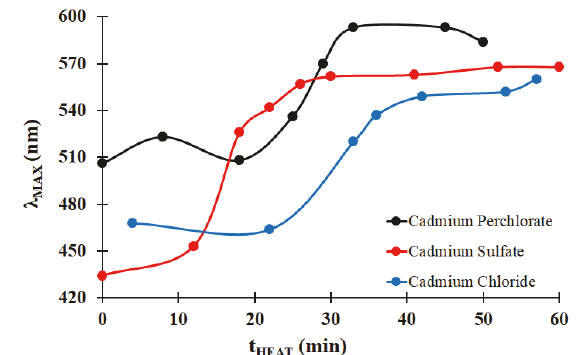
Figure 1: Fluorescence spectra of mercaptosuccinic acid-modified CdSe QDs. Different metal salts were used, with corresponding 𝜆 MAX values (acetate = 605 nm [fwhm = 111 nm], chloride = 610 nm [fwhm = 134 nm], nitrate = 617 nm [fwhm = 108 nm], and sulfate = 612 nm [fwhm = 176 nm]).